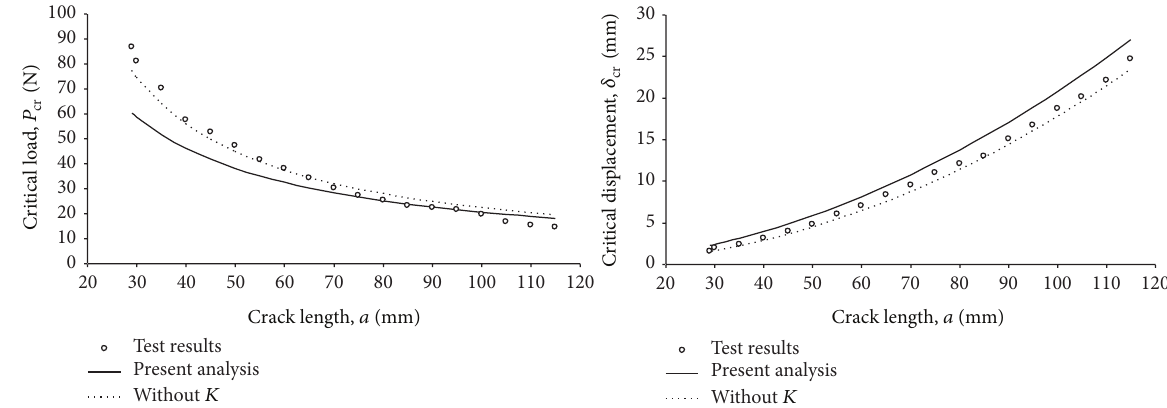
) and the corresponding displacement (𝛿 ) cr cr